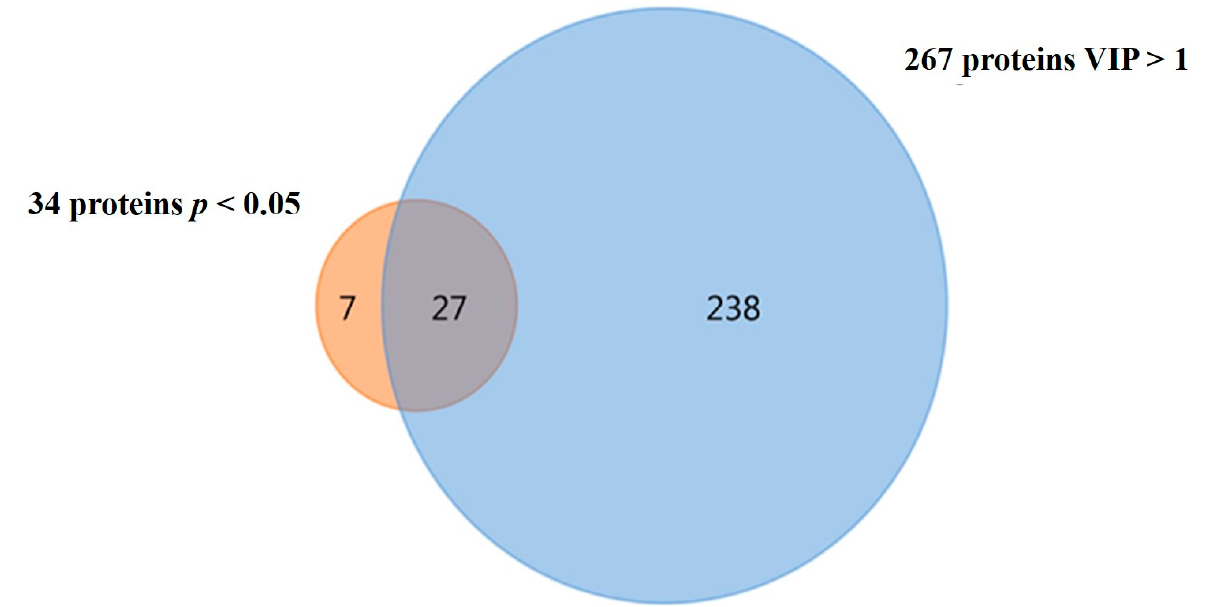
Figure 3. Venn diagram showing that 27 proteins were common between the signi fi cant proteins from the univariate analysis (Kruskal–Wallis, p < 0.05) and the multivariate analysis (PLS-DA, VIP > 1). Table 1. Details of the twenty-seven proteins with higher interest, selected from the combination of the multivariate (PLS-DA) and the univariate statistical analysis (Kruskal–Wallis), detected in P. halepensis EMs induced under di ff erent temperature treatments: Cond1: 23 °C; Cond2: 40 °C (4 h); Cond3: 50 °C (30 min); Cond4: 60 °C 5 (min). Fold Change Kruskal–Wallis